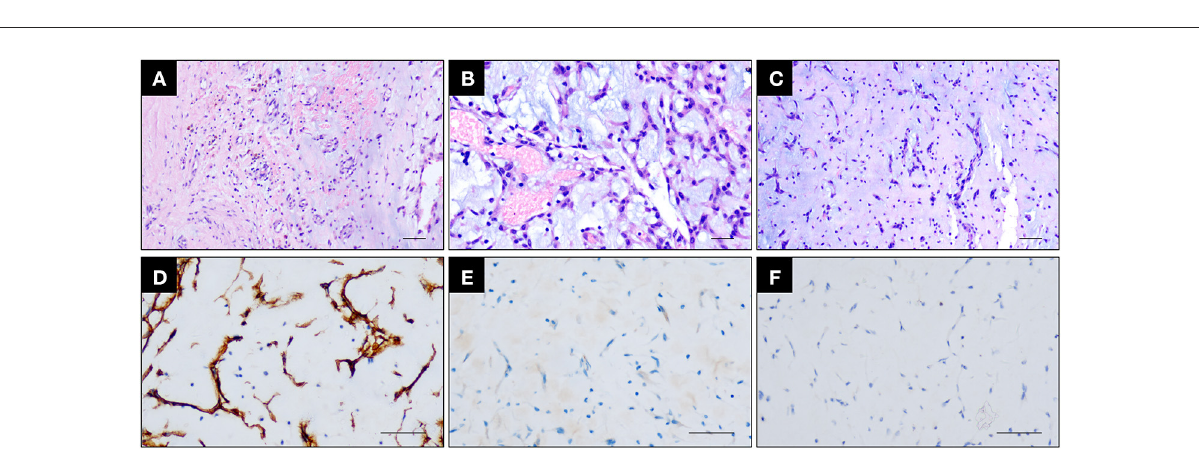
FIGURE8 (A–C) Hematoxylin and eosin staining showing the cardiac myxoma attached to the atrial wall (A) and the enrichment of small plump spindle to ovoid tumor cells with abundant eosinophilic cytoplasm and minimal cytologic atypia (B) growing in aggregates and embedded within the myxoid stroma (C) . Scale bar = 100 µ m. (D, E) Immunohistochemical staining showing that myxoma cells express CD34 (D) but do not express SMA (E) . Scale bar = 100 µ m. (F) Immunohistochemical staining of Ki67 showing that myxoma cells are with very low proliferation index. Scale bar = 100 µ m.